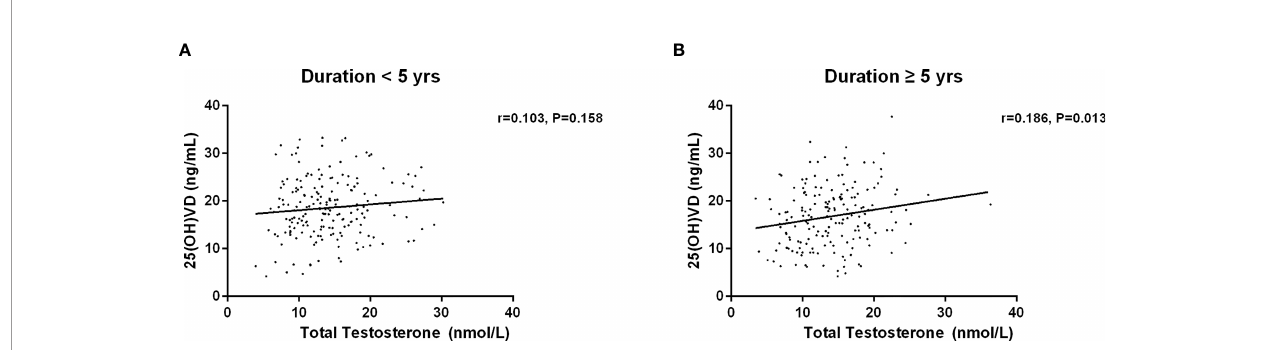
FIGURE 3 | Relationship between serum 25(OH)D and total testosterone in patients with duration less than 5 years (n=189) and more than 5 years (n=178). (A) Patients with duration < 5 years; (B) Patients with duration ≥ 5